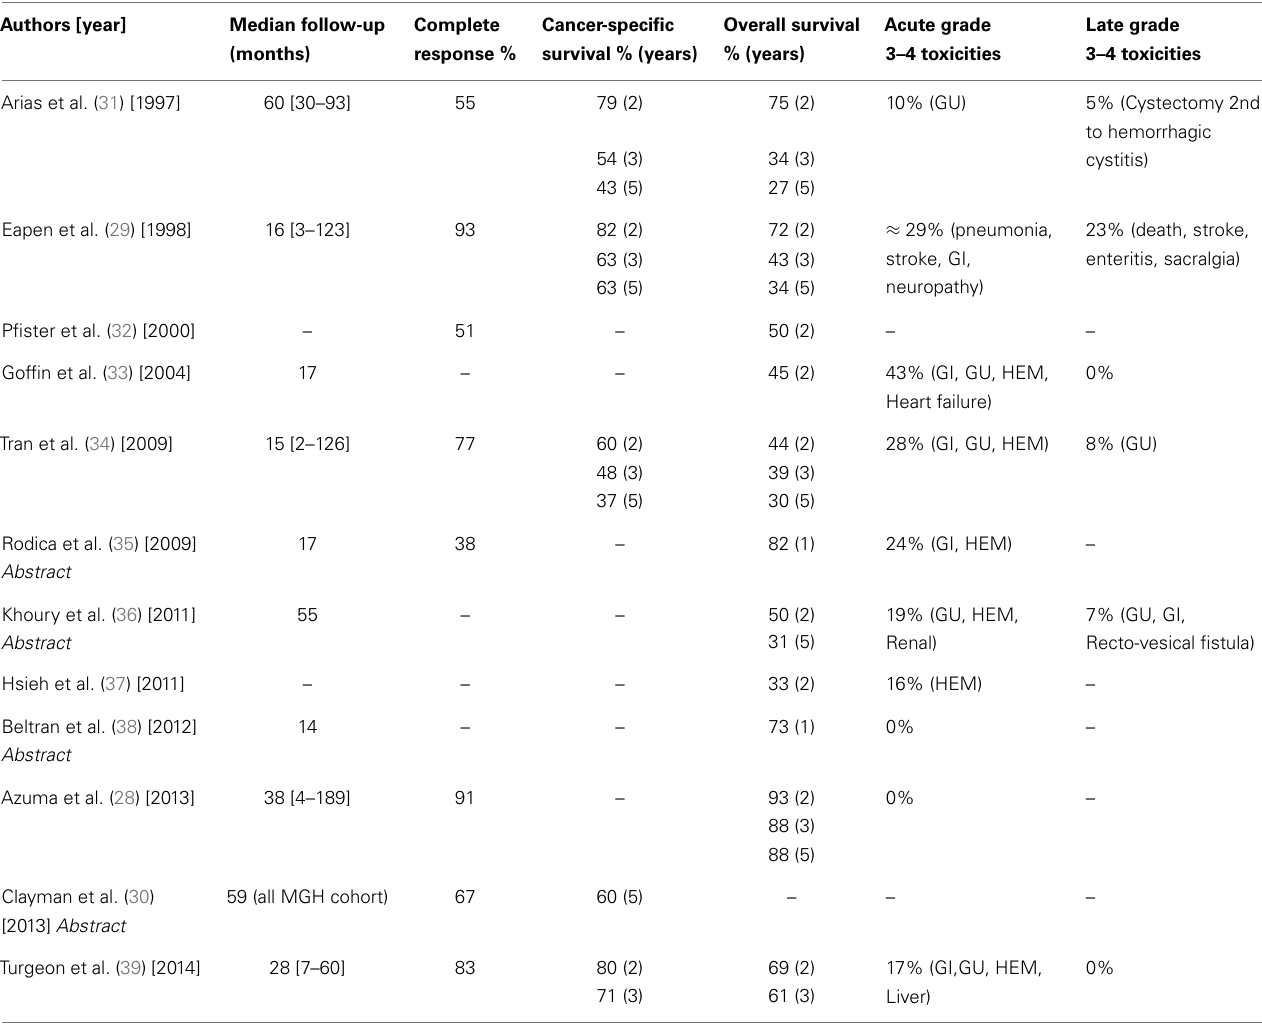
Table 2 | Median follow-up, outcomes, and toxicities